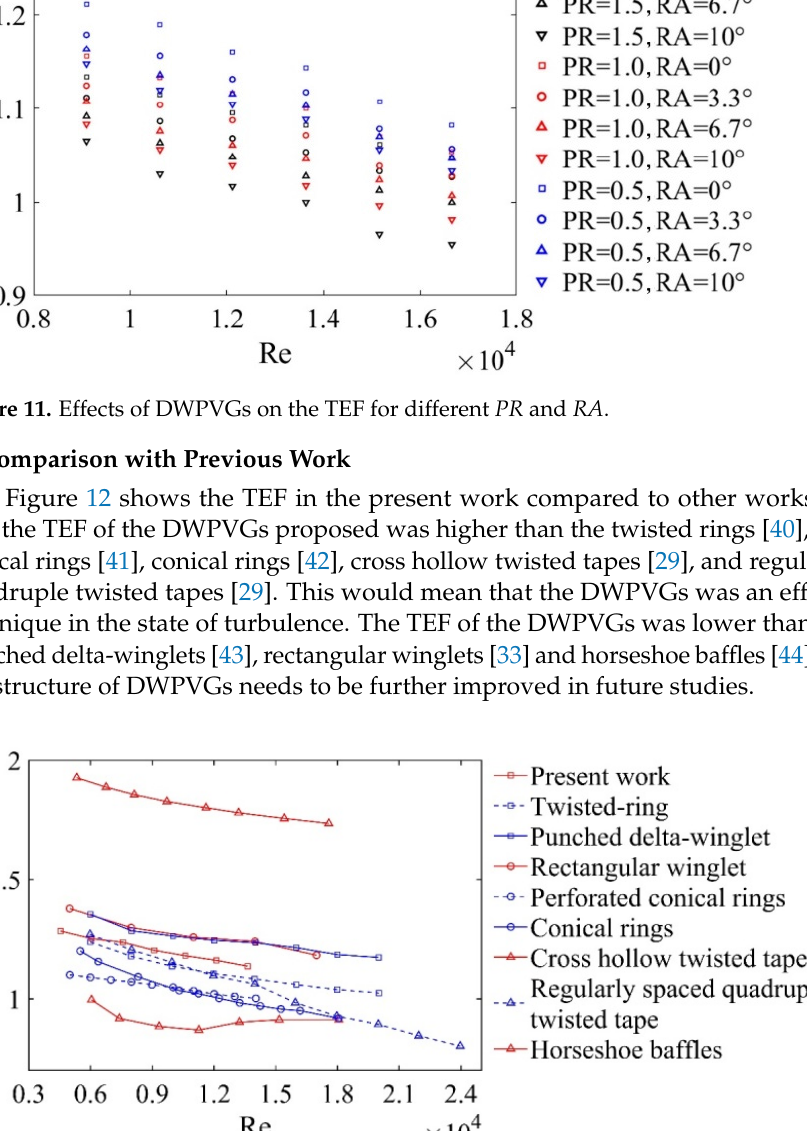
Figure 10. Effects of vortex generators on the f for different PR s and RA s. ( a ) the relationship be- tween Re and f with different PR s and RA s; ( b ) the relationship between the friction efficient ratio